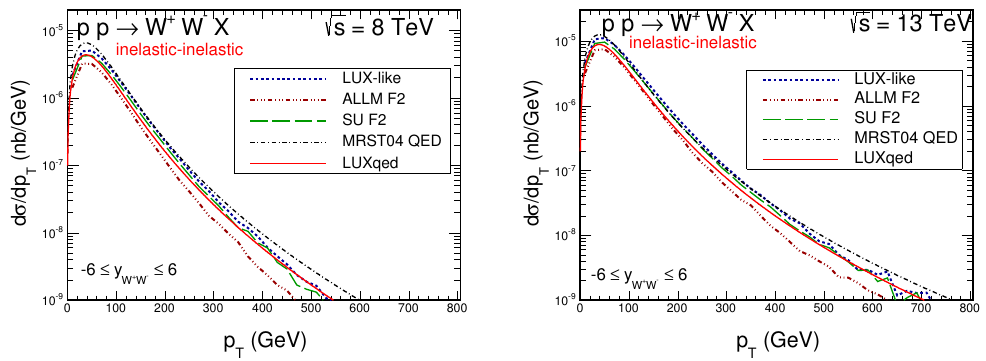
p s = 8 TeV, while the right panel shows